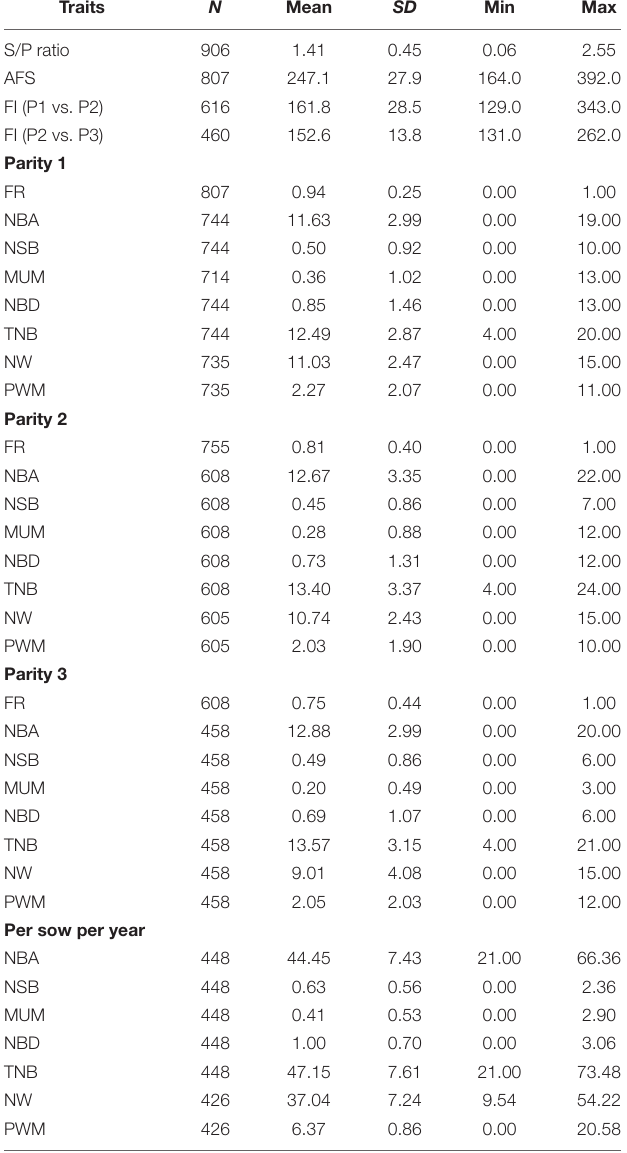
TABLE 1 | Descriptive statistics of the